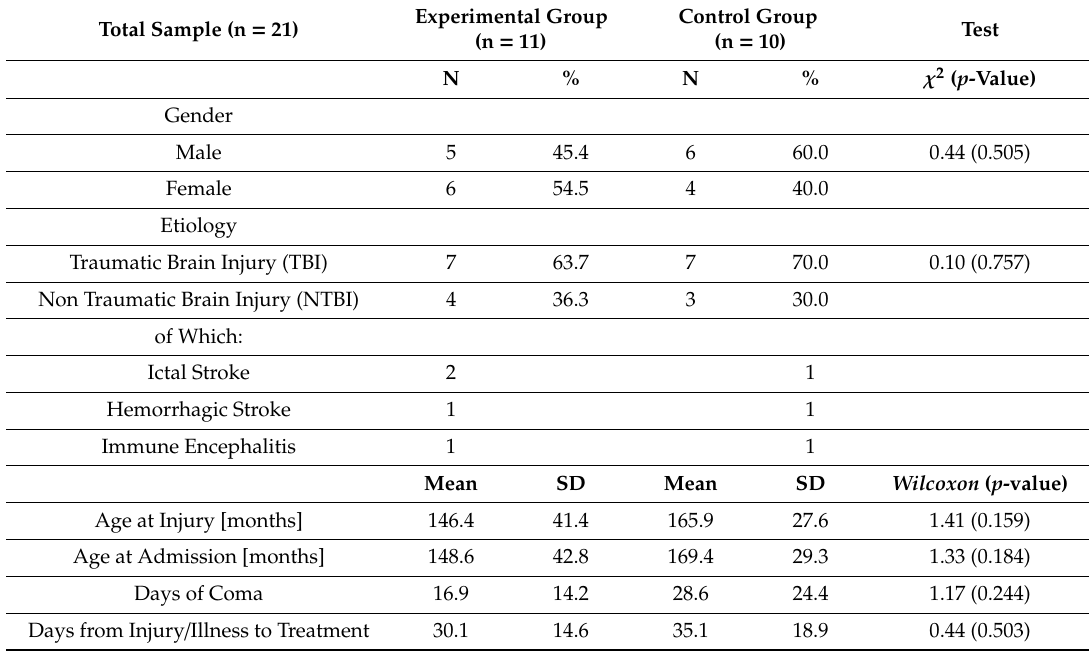
Table 1. Clinical and demographic characteristics and intelligence quotient of the sample at